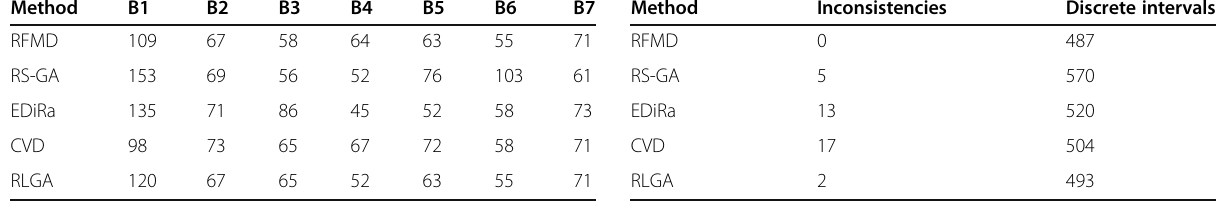
Table 1 Number of discrete intervals in each band of Landsat 8 image